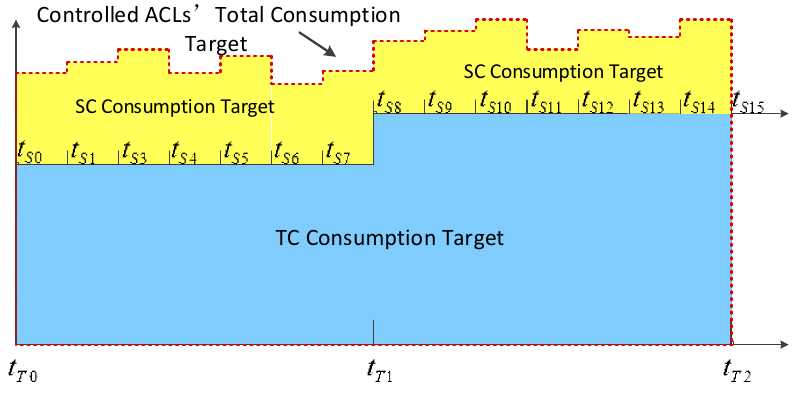
Figure 2. Diagram of two-stage ACLs control method.